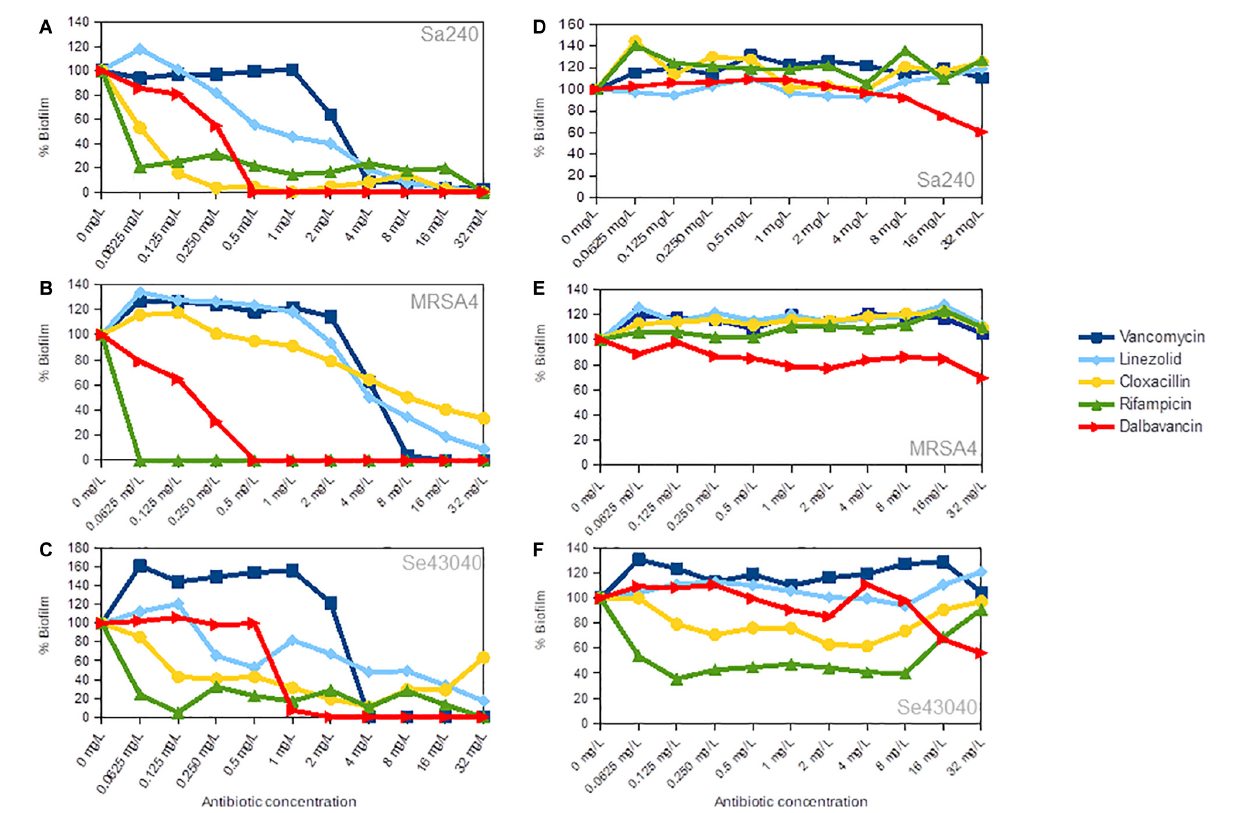
FIGURE 2 | Concentration-dependent effect of linezolid, vancomycin, cloxacillin, rifampicin, and dalbavancin on biofilms in Staphylococcus aureus 240, S. aureus MRSA4, and Staphylococcus epidermidis 43040 strains. (A–C) The antibiotics were added at the beginning of the experiment together with the bacterial inoculum. (D–F) The antibiotics were added when biofilms were already formed, at their exponential growth phase. All charts indicate biofilm formation at 20 h of growth expressed as the percentage of cell index (CI) compared with the control without antibiotic. Values below 100% indicate biofilm inhibition, whereas values over 100% indicate biofilm induction, in comparison with the biofilm mass achieved in the absence of each antibiotic.